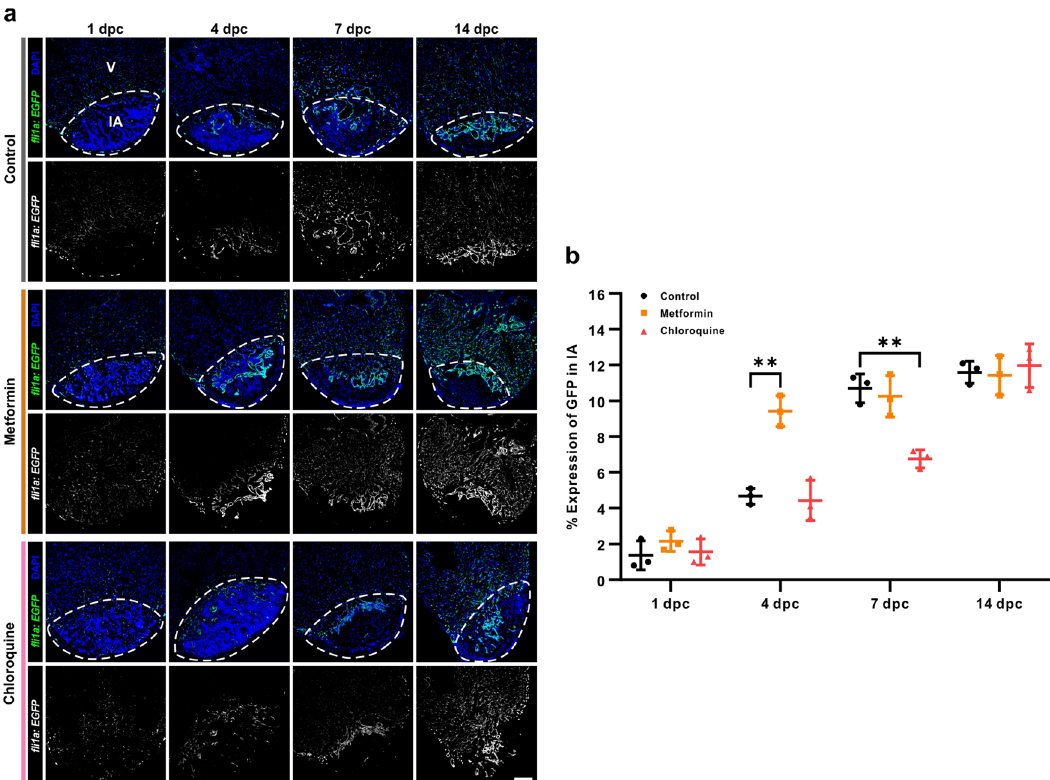
Fig. 4 Metformin accelerates regeneration of the endocardium and vascular endothelium. a After heart cryoinjury, the Tg ( fl i1a : EGFP ) fi sh, which express EGFP speci fi cally in the endocardium and vascular endothelium, were maintained in untreated fi sh water (control) or in fi sh water containing 50 µM metformin or 100 µM CQ for 1 – 14 days. The hearts were then isolated, fi xed, sectioned and immunostained with an anti-GFP antibody (in green), and co-labeled with DAPI to show the nuclei (in blue). V: ventricle; IA: injured area. Scale bar: 100 µm. b The percentage of Fli1a expressing cells in the injured area of the control, metformin and CQ treated fi sh at 1 dpc, 4 dpc, 7 dpc, and 14 dpc was quanti fi ed. The data are presented as mean ± SD, n = 3 hearts, ** P < 0.01 vs